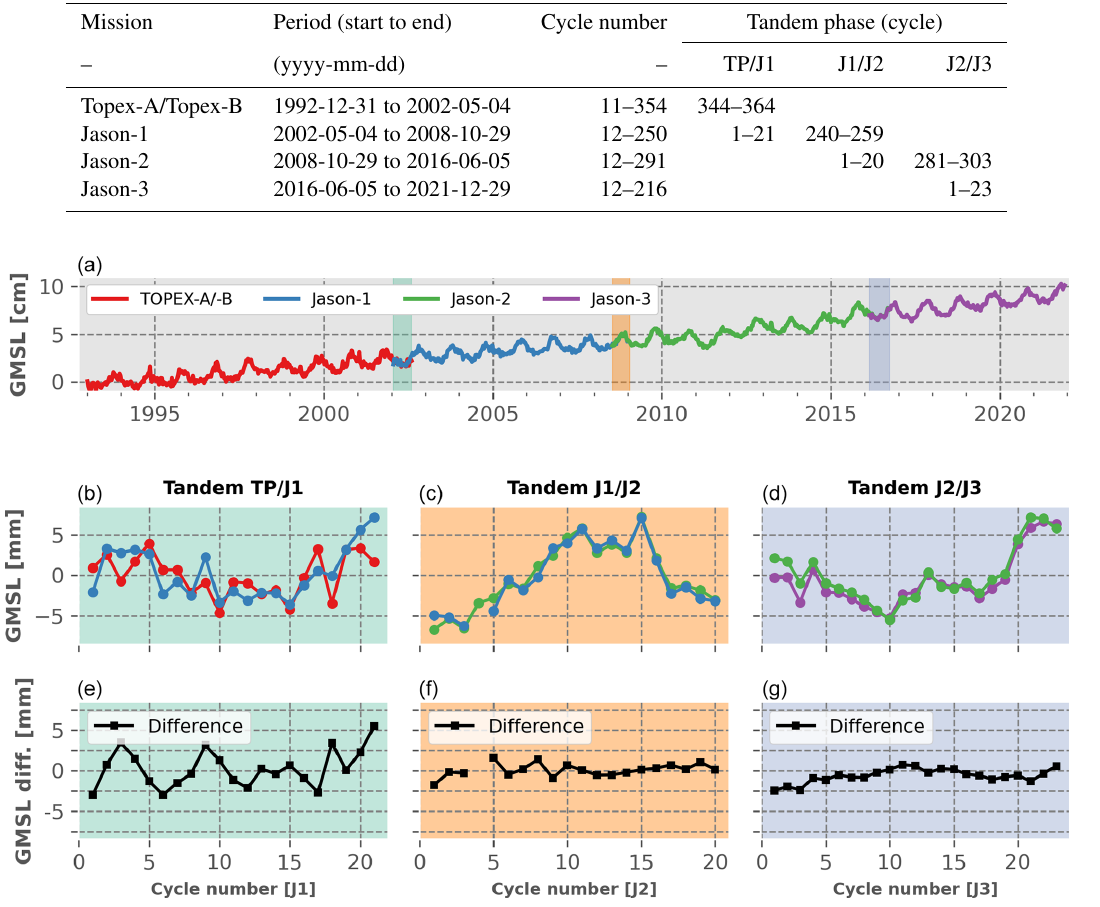
Figure 1. GMSL record of the reference missions with a focus on the respective tandem phases. Panel (a) indicates the position in time of the respective tandem phases. Panels (b–d) show zooms on the GMSL records over the tandem phases, and (e–g) show the GMSL record differences between the two respective missions in tandem phase (the mean values of the time series have been removed to ease the comparison between tandem